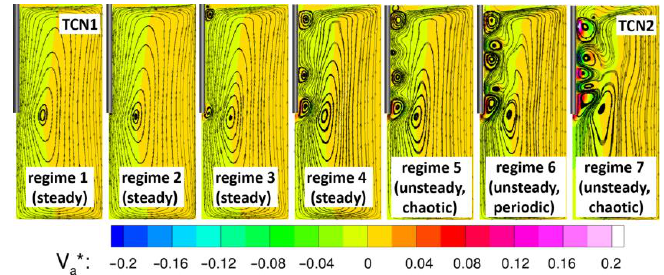
Figure 13. Typical flow structures relative the various regimes of Figure 12. A sample state is reported for the unsteady cases (regimes 5, 6 and 7).